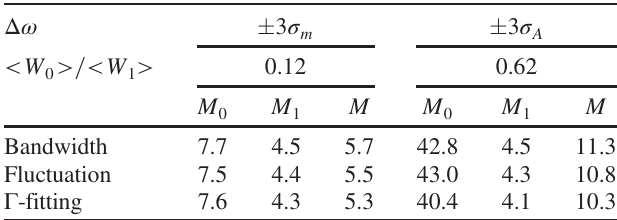
TABLE II. The number of modes of the SASE ( M 0 ), seed ( M 1 ) and sum signal ( M ) at full seed ( (cid:2) 3 σ m ) and full SASE ( (cid:2) 3 σ A ) bandwidth.